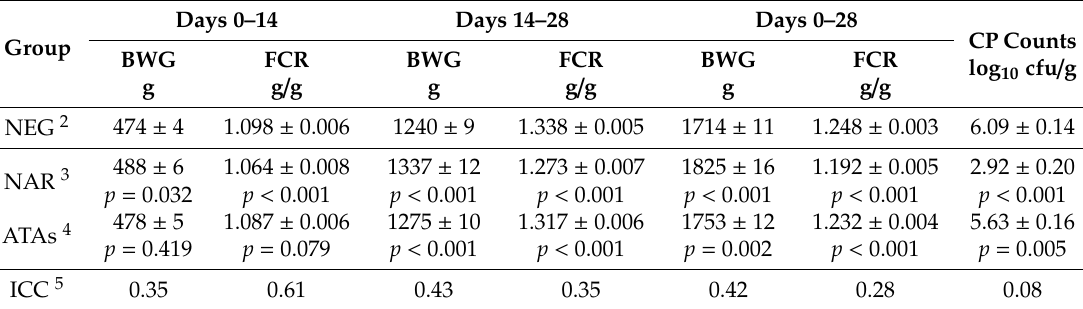
Table 3. Body weight gain, feed conversion ratio and Clostridium perfringens counts for negative control, narasin and alternatives to antibiotics 1